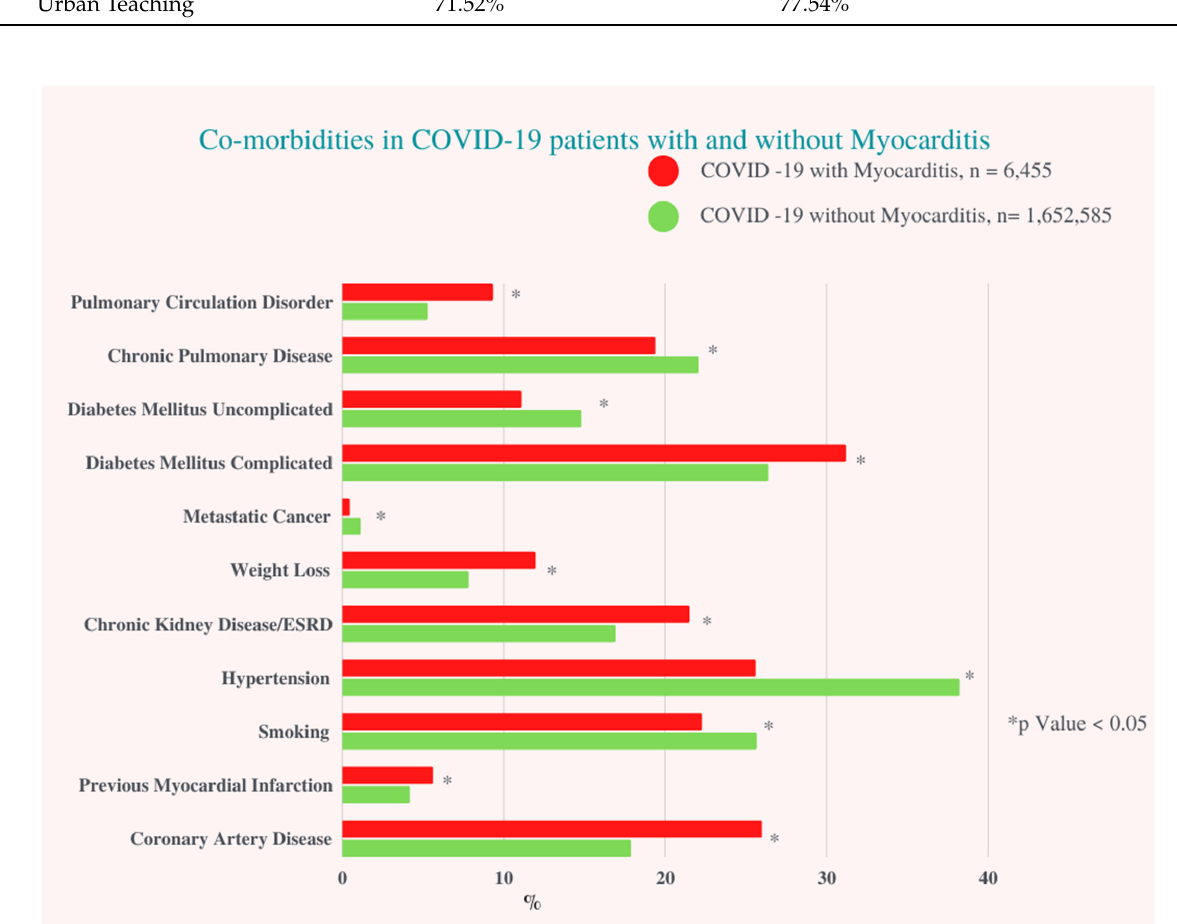
Figure 1. Co-morbidities in COVID-19 Patients with and without Myocarditis. ESRD: End Stage Renal Artery Disease. Table 1. COVID-19 and Myocarditis Unmatched Patient-level Characteristics.